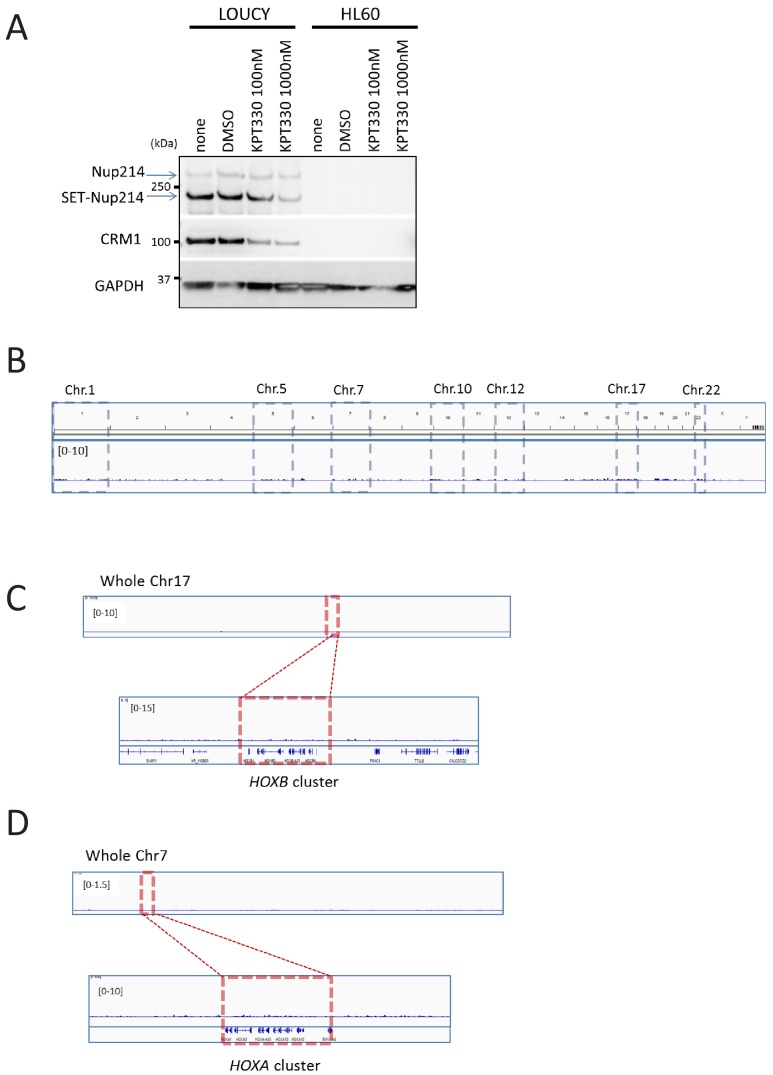
Protein expression and CRM1 binding profiles in HL60 cells.(A) Protein expression of Nup214, SET-Nup214, CRM1, and GAPDH. LOUCY and HL60 cell lines were cultured in the absence or presence of DMSO (vehicle control) or KPT-330 (100 nM or 1000 nM) for 24 hr; cell lysates were prepared using RIPA buffer and analyzed by immunoblotting with anti-Nup214, anti-CRM1, or anti-GAPDH antibodies. (B–D) CRM1 ChIP-seq for HL60 cells was performed as described in Figure 1. (B: whole genome; C: whole chromosome 17 and HOXB cluster, D: whole chromosome seven and HOXA cluster).